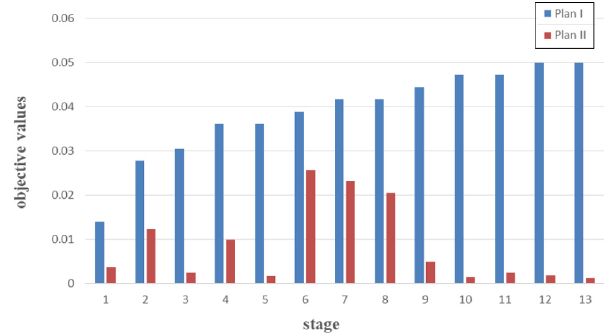
Figure 6 Comparisons in objective values between Plan I and Plan